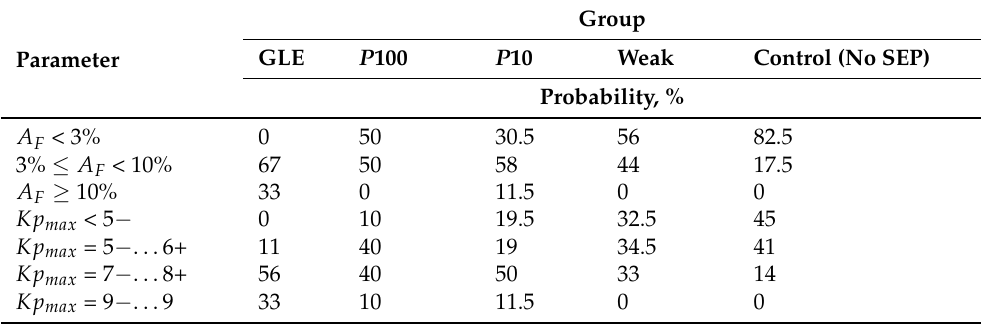
Table 3. Probability of registering (in %) various values of FD amplitude and maximum geomagnetic Kp -indices after solar flares plus CME events with certain